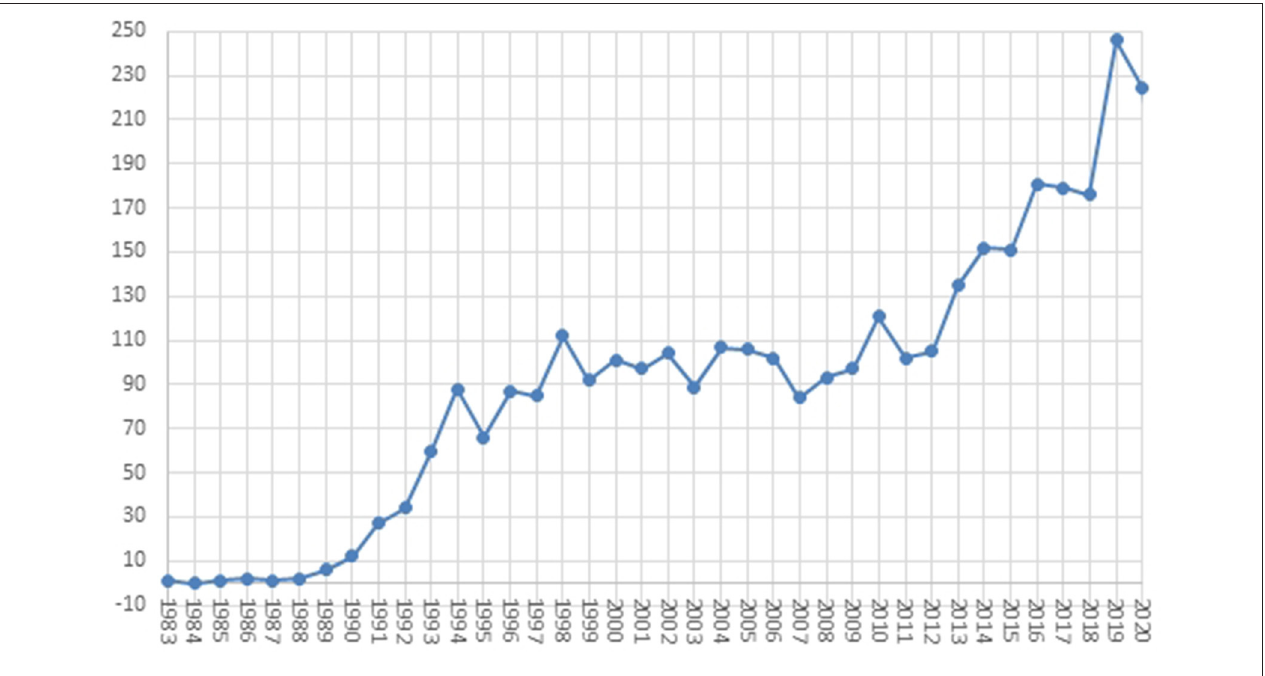
FIGURE 1 | Trend in the number of